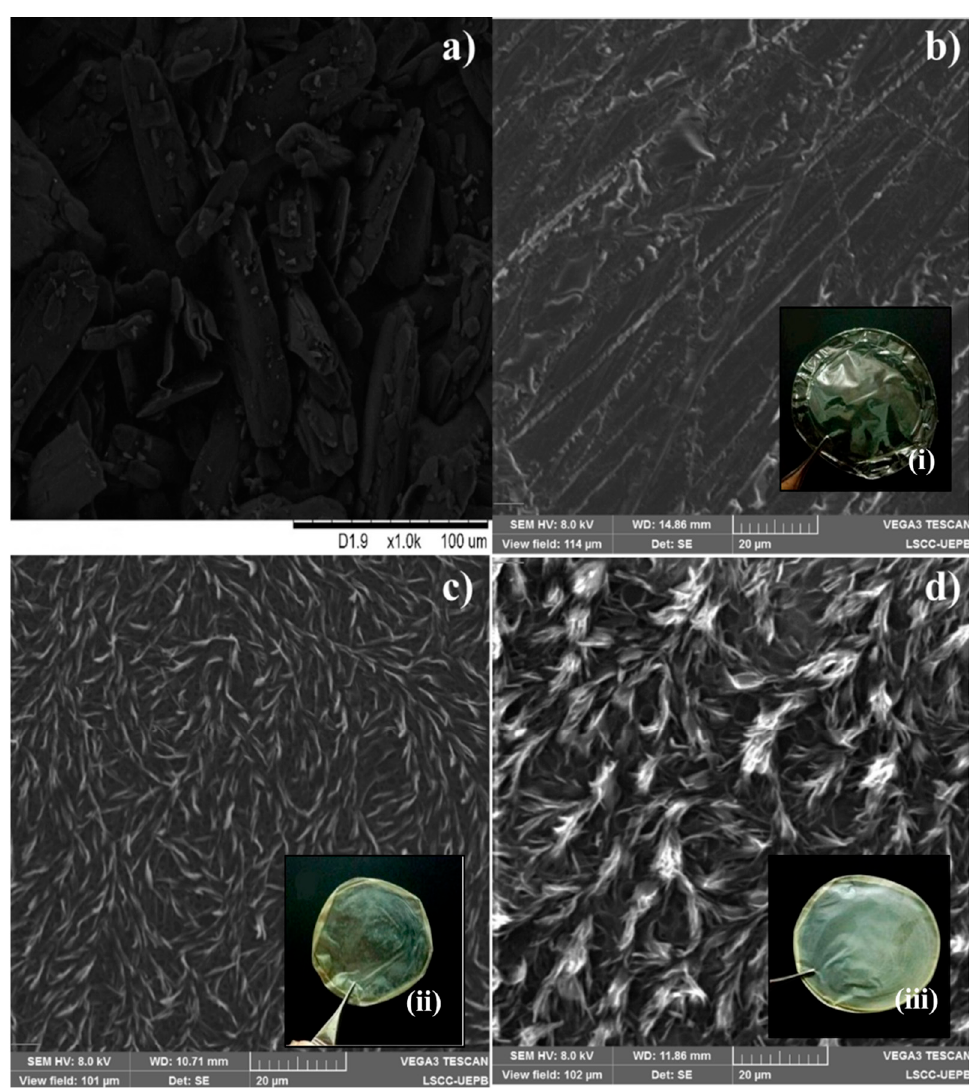
Figure 1. Surface morphology of PTX (pentoxifylline) ( a ), CSF (chitosan films) ( b ), F1 (2.0 mg/mL of pentoxifylline) ( c ), F2 (4.0 mg/mL of pentoxifylline) ( d ) at 20 µ m scale. Photomacrographs CSF ( i ), F1 ( ii ), and F2 ( iii